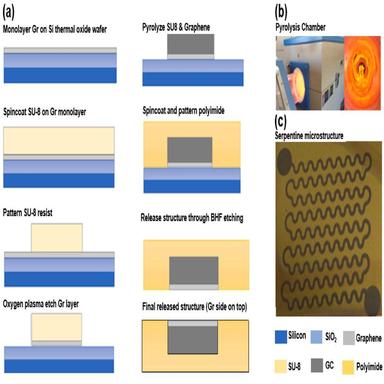
(a) Patterning and synthesis process for GrGC microstructure, (b) tube-furnace for synthesis, and (c) the ensuing GrGC serpentine microstructure (line width = 50 μm, electrode diameter = 3 mm). (A colour version of this figure can be viewed online.)